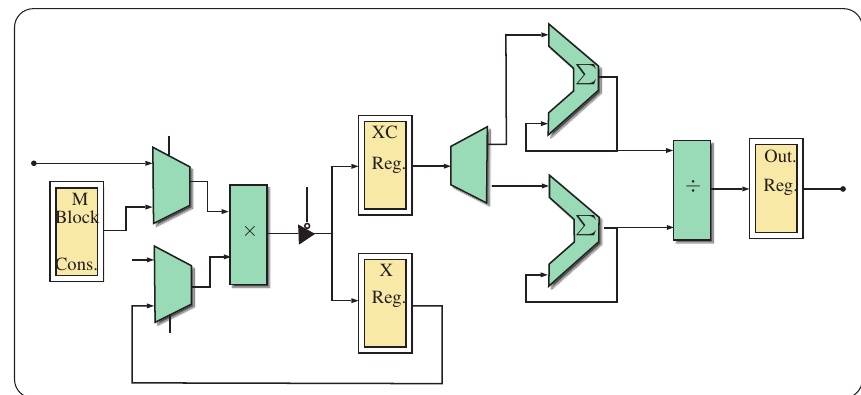
Figure 5. Architecture for the approximated hyperbolic tangent